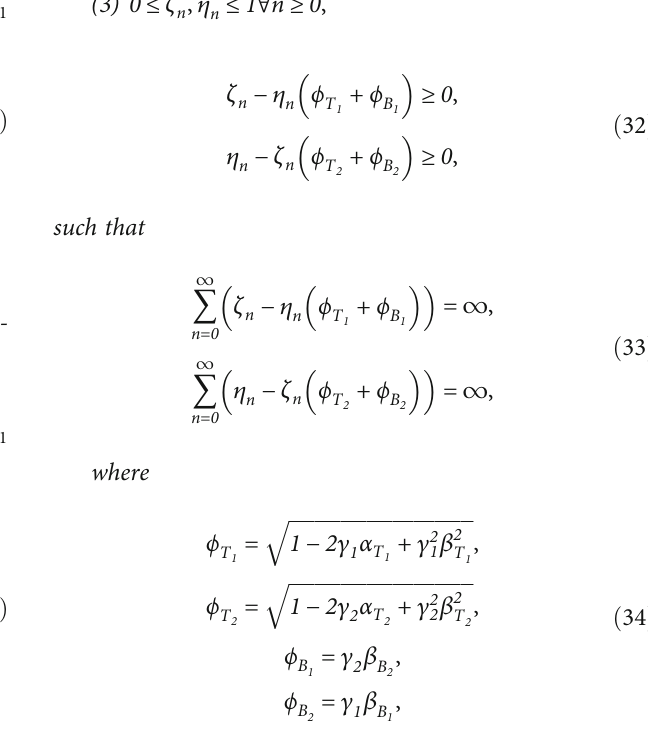
Algorithm 4. For given y 0 ∈ K 2 and x 0 ∈ K 1 , compute x n +1